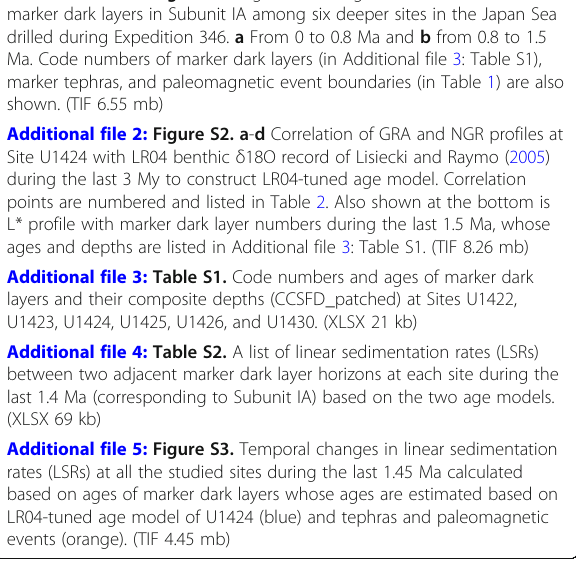
Additional file 1: Figure S1. Figures showing inter-site correlation of marker dark layers in Subunit IA among six deeper sites in the Japan Sea drilled during Expedition 346. a From 0 to 0.8 Ma and b from 0.8 to 1.5 Ma. Code numbers of marker dark layers (in Additional file 3: Table S1), marker tephras, and paleomagnetic event boundaries (in Table 1) are also shown. (TIF 6.55 mb) Additional file 2: Figure S2. a - d Correlation of GRA and NGR profiles at Site U1424 with LR04 benthic δ 18O record of Lisiecki and Raymo (2005) during the last 3 My to construct LR04-tuned age model. Correlation points are numbered and listed in Table 2. Also shown at the bottom is L* profile with marker dark layer numbers during the last 1.5 Ma, whose ages and depths are listed in Additional file 3: Table S1. (TIF 8.26 mb) Additional file 3: Table S1. Code numbers and ages of marker dark layers and their composite depths (CCSFD_patched) at Sites U1422, U1423, U1424, U1425, U1426, and U1430. (XLSX 21 kb) Additional file 4: Table S2. A list of linear sedimentation rates (LSRs) between two adjacent marker dark layer horizons at each site during the last 1.4 Ma (corresponding to Subunit IA) based on the two age models. (XLSX 69 kb) Additional file 5: Figure S3. Temporal changes in linear sedimentation rates (LSRs) at all the studied sites during the last 1.45 Ma calculated based on ages of marker dark layers whose ages are estimated based on LR04-tuned age model of U1424 (blue) and tephras and paleomagnetic events (orange). (TIF 4.45